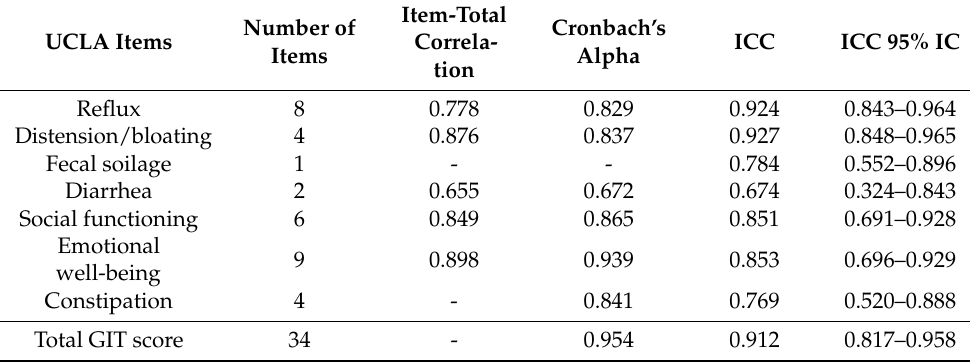
Table 5. UCLA GIT 2.0 reliability